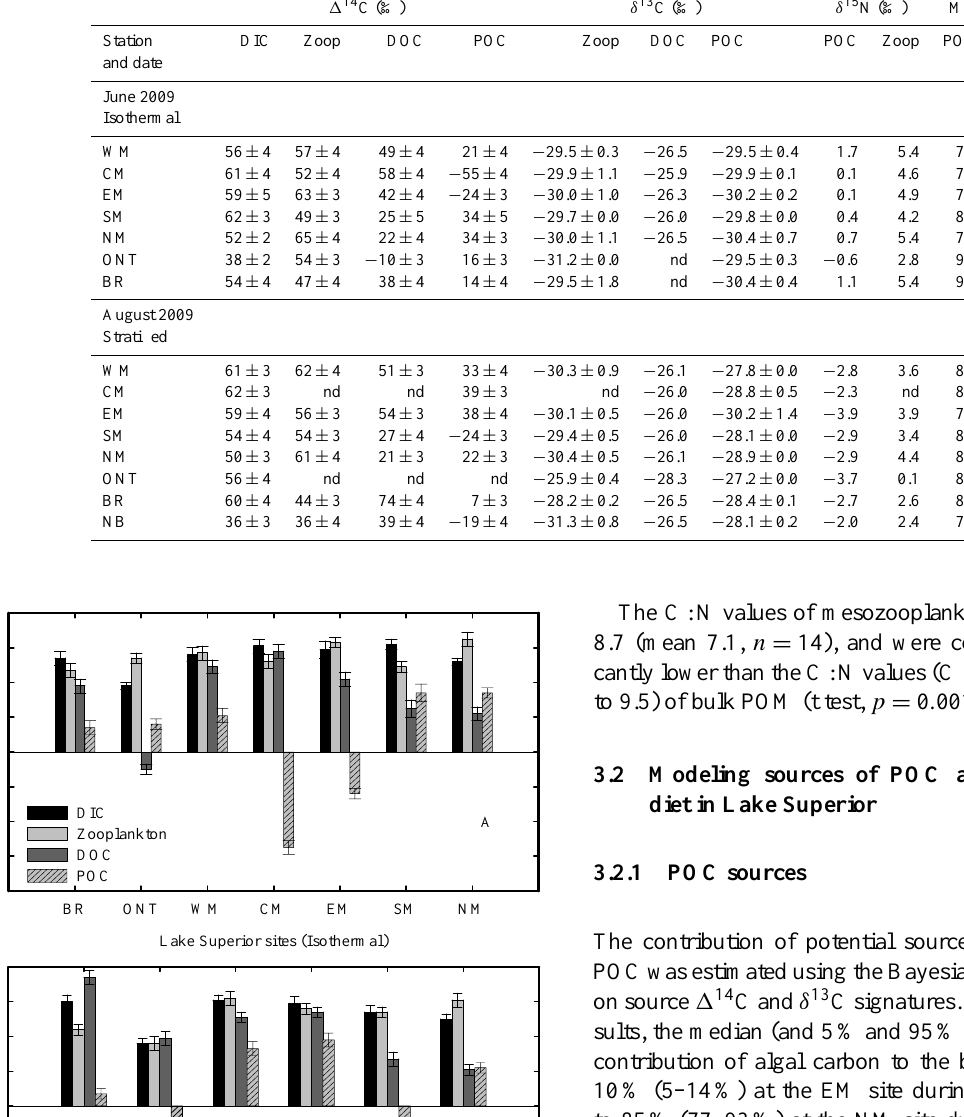
to 85 % (77–93 %) at the NM site during isothermal condi- tion (Table 3). The median contribution of terrestrial carbon to bulk POM ranged from 1 % (0.1–5 %) at EM site during isothermal condition to 19 % (2–47 %) at the WM site during stratification (Table 3). Sedimentary OC influence on bulk POM varied from a median of 10 % (2–15 %) during stratifi- cation at WM site to 87 % (84–91 %) during isothermal con- dition at EM site (Table 3). The average lake-wide (includ- Figure 2. Fig. 2. 1 14 C values for DIC, Mesozooplankton, DOC, and POC ing both seasons) median contributions of algal, terrestrial, samples in (A) the isothermal lake in June, and (B) the stratified sedimentary, and bacterial OC to the bulk POM were 58 %, lake in August 2009. 4 %, 34 %, and 2 % (Table 3), and the corresponding values with creek POC as terrestrial endmember were 58 %, 6 %, 32 %, and 3 %, respectively (Table 3). It should be noted that these model estimates change to 23 %, 28 %, 15 %, and 25